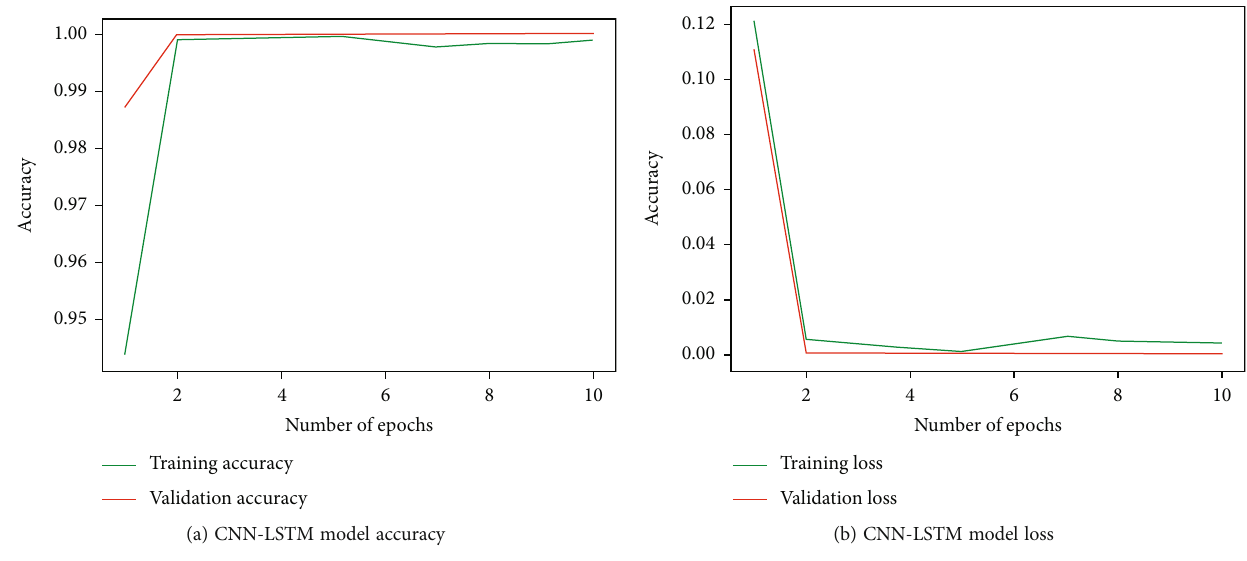
Figure 6: Performance plot of the CNN-LSTM and model using numerical data. Table 4: Signi fi cant results of the CNN-BiLSTM against existing